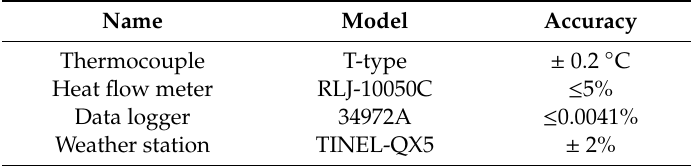
Figure 5. Main test equipment: ( a ) Weather station; ( b ) Data acquisition instrument. Table 5. Parameters of measuring tools.